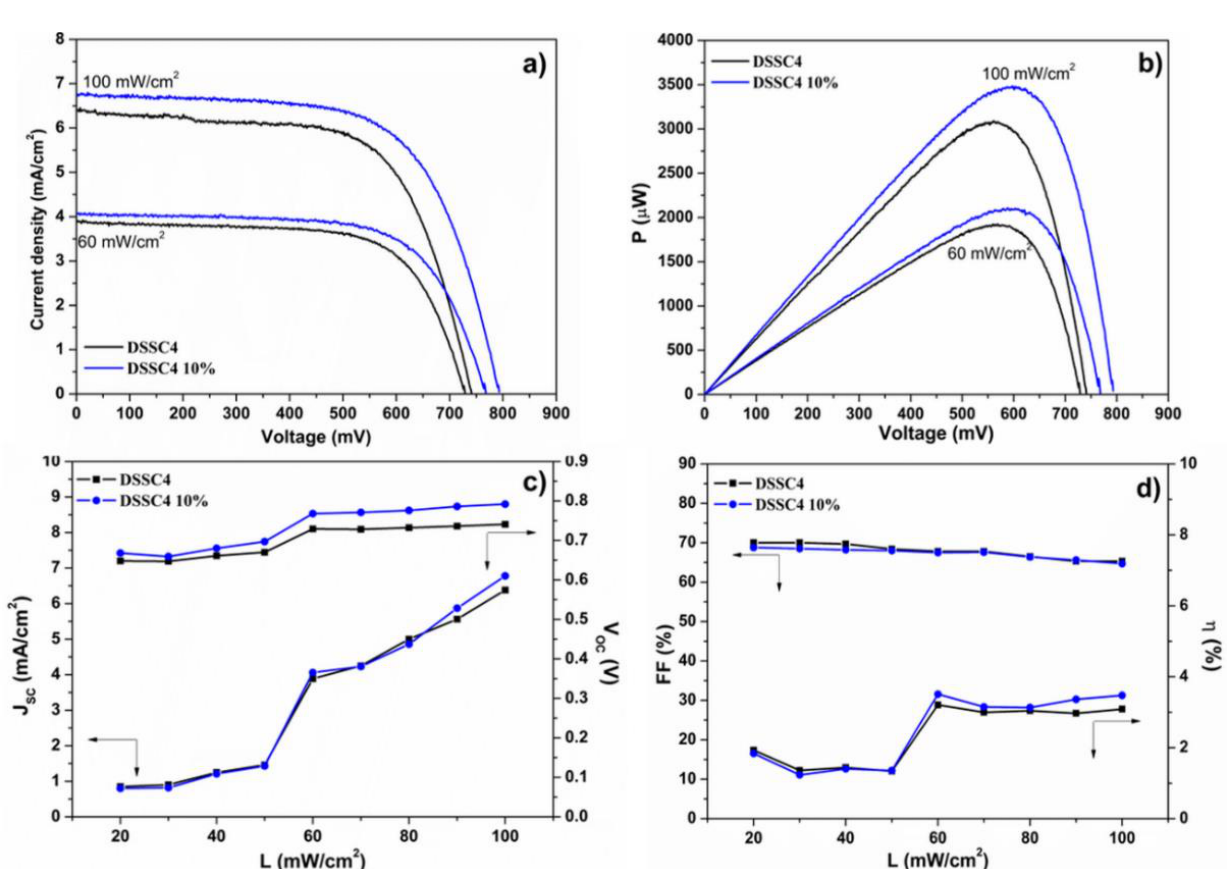
Figure 12. The photovoltaic performance of DN-F01 sensitized DSSC4 under different illumination intensities tested using E and E10% electrolytes: ( a ) J – V characteristics; ( b ) voltage dependence of the calculated power P; ( c ) dependence of V OC and J SC on the illumination intensity; ( d ) dependence of efficiency and fill factor on the illumination